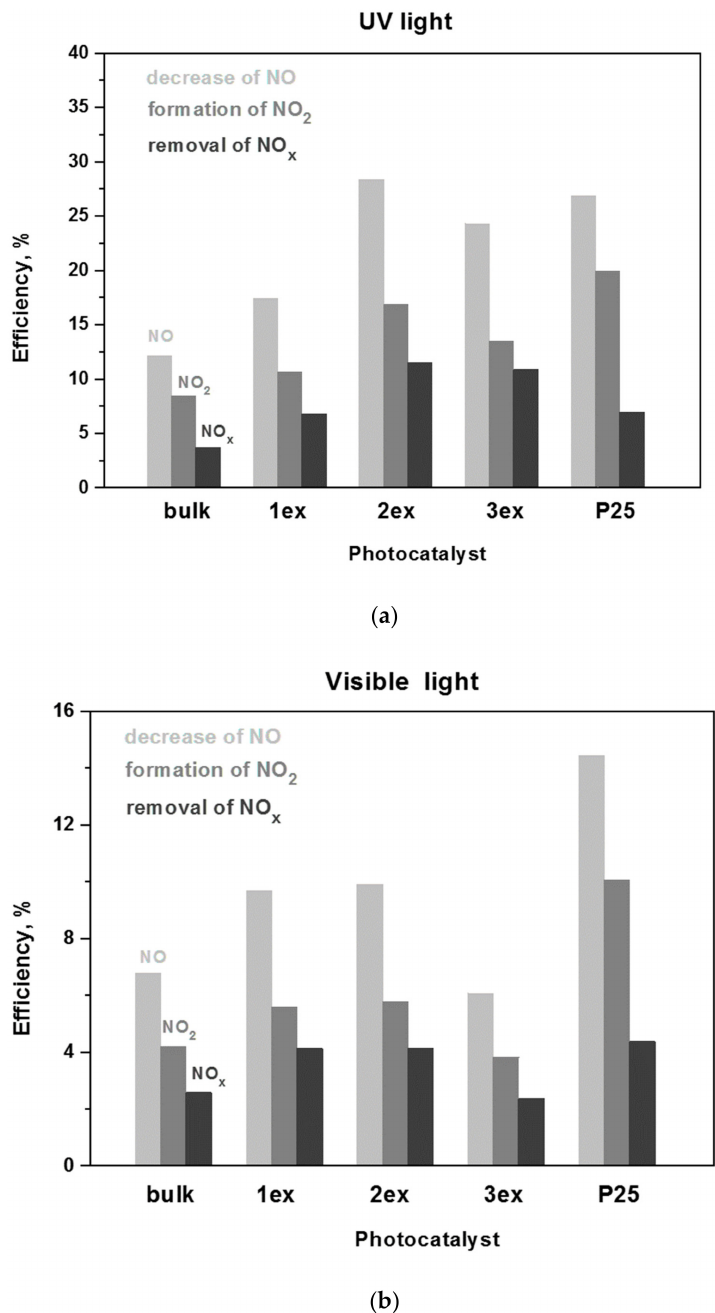
Figure 14. E ffi ciency of the g-C 3 N 4 (bulk, 1ex, 2ex and 3ex) and P25 in NO oxidation and NO x removal under UV ( a ) and visible light ( b )